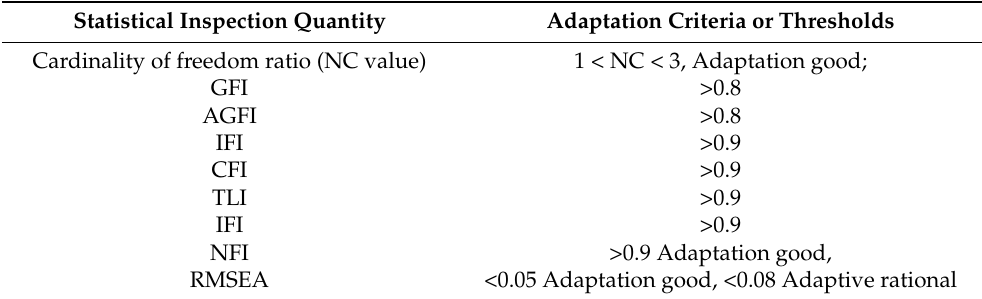
Table 7. Main evaluation indexes and standards of overall suitability of the model.